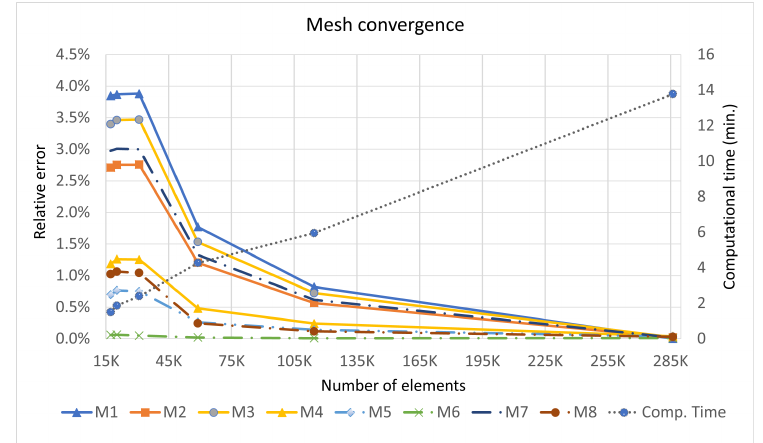
Figure 4. Mesh convergence study for the solid